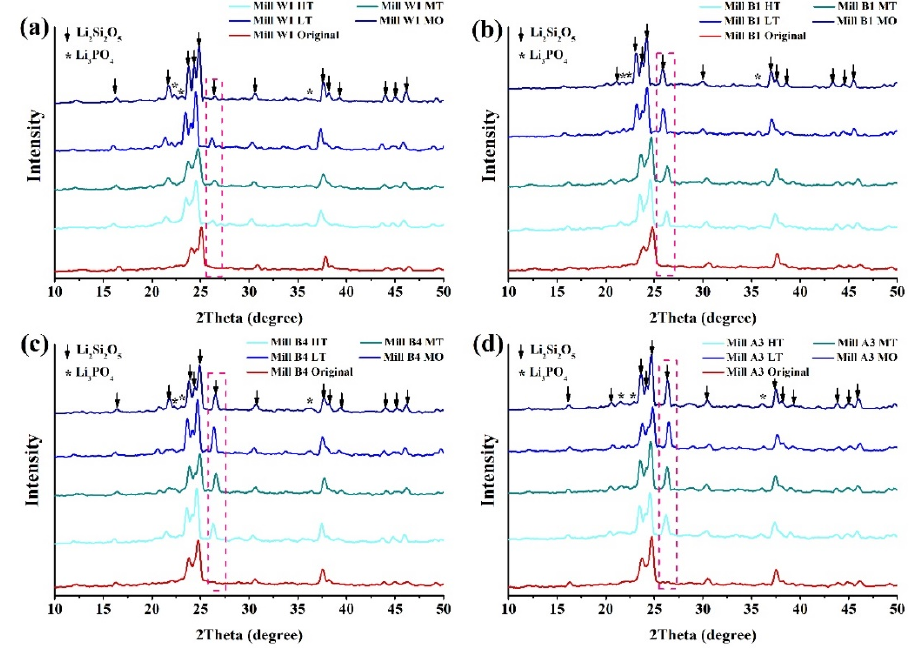
Figure 8. XRD representative patterns of the Amber Mill ceramics. ( a ) W1, ( b ) B1, ( c ) B4, and ( d ) A3.